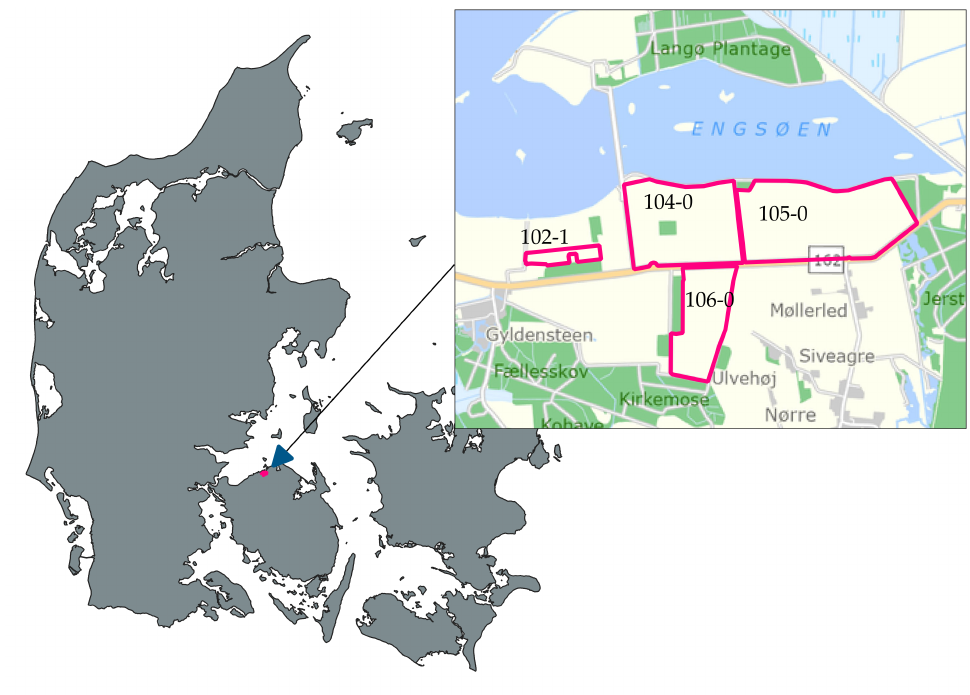
Figure 1. Placement of the test fields within Danish boundary (maps available free from